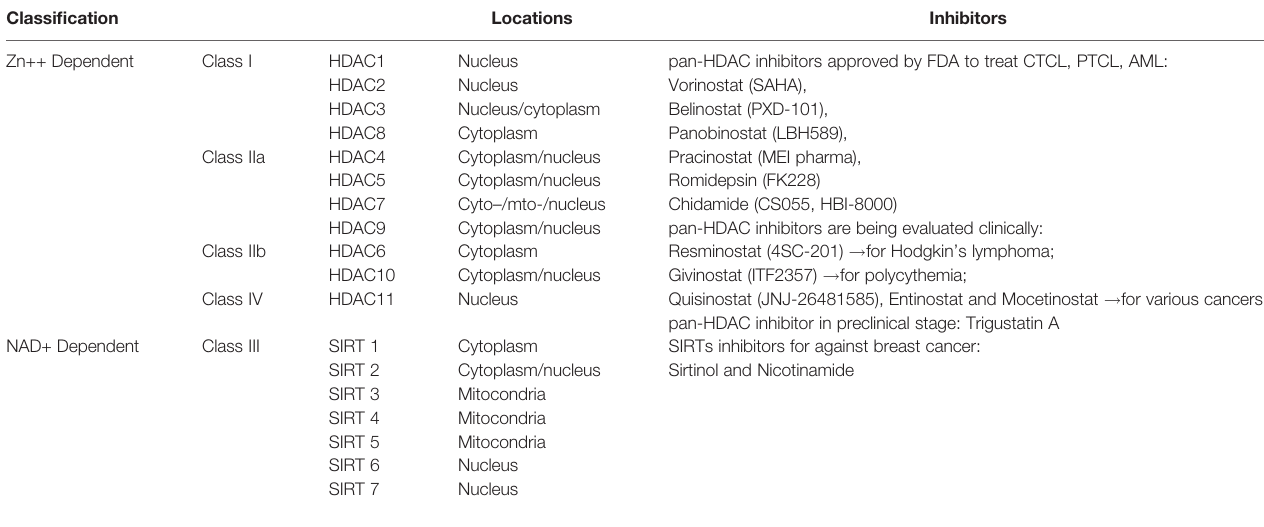
TABLE 2 | Classi fi cation of histone deacetylases (HDACs) and their inhibitors. Classi fi